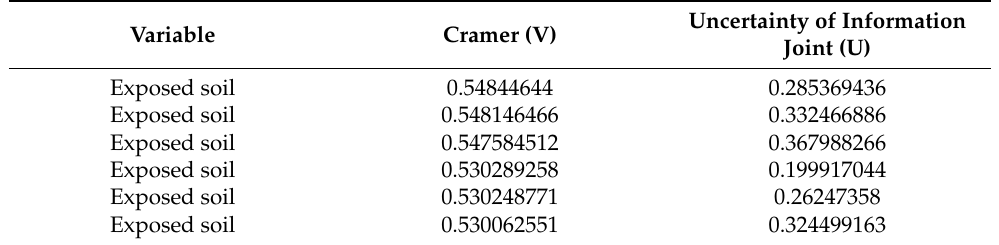
Table 3. Higher Cramer Index and Joint Information Uncertainty values in the model variables.